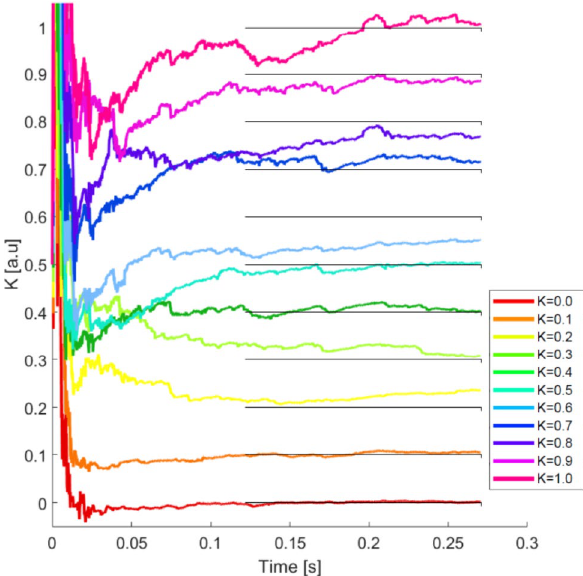
Figure 3. UKF estimations obtained from the observations y 1 and y 2 for K parameters ranging from 0 to 1. The solid black lines indicate the values of the K parameters to be estimated during the filtering. The estimated values converge, in all cases, independently of the levels of